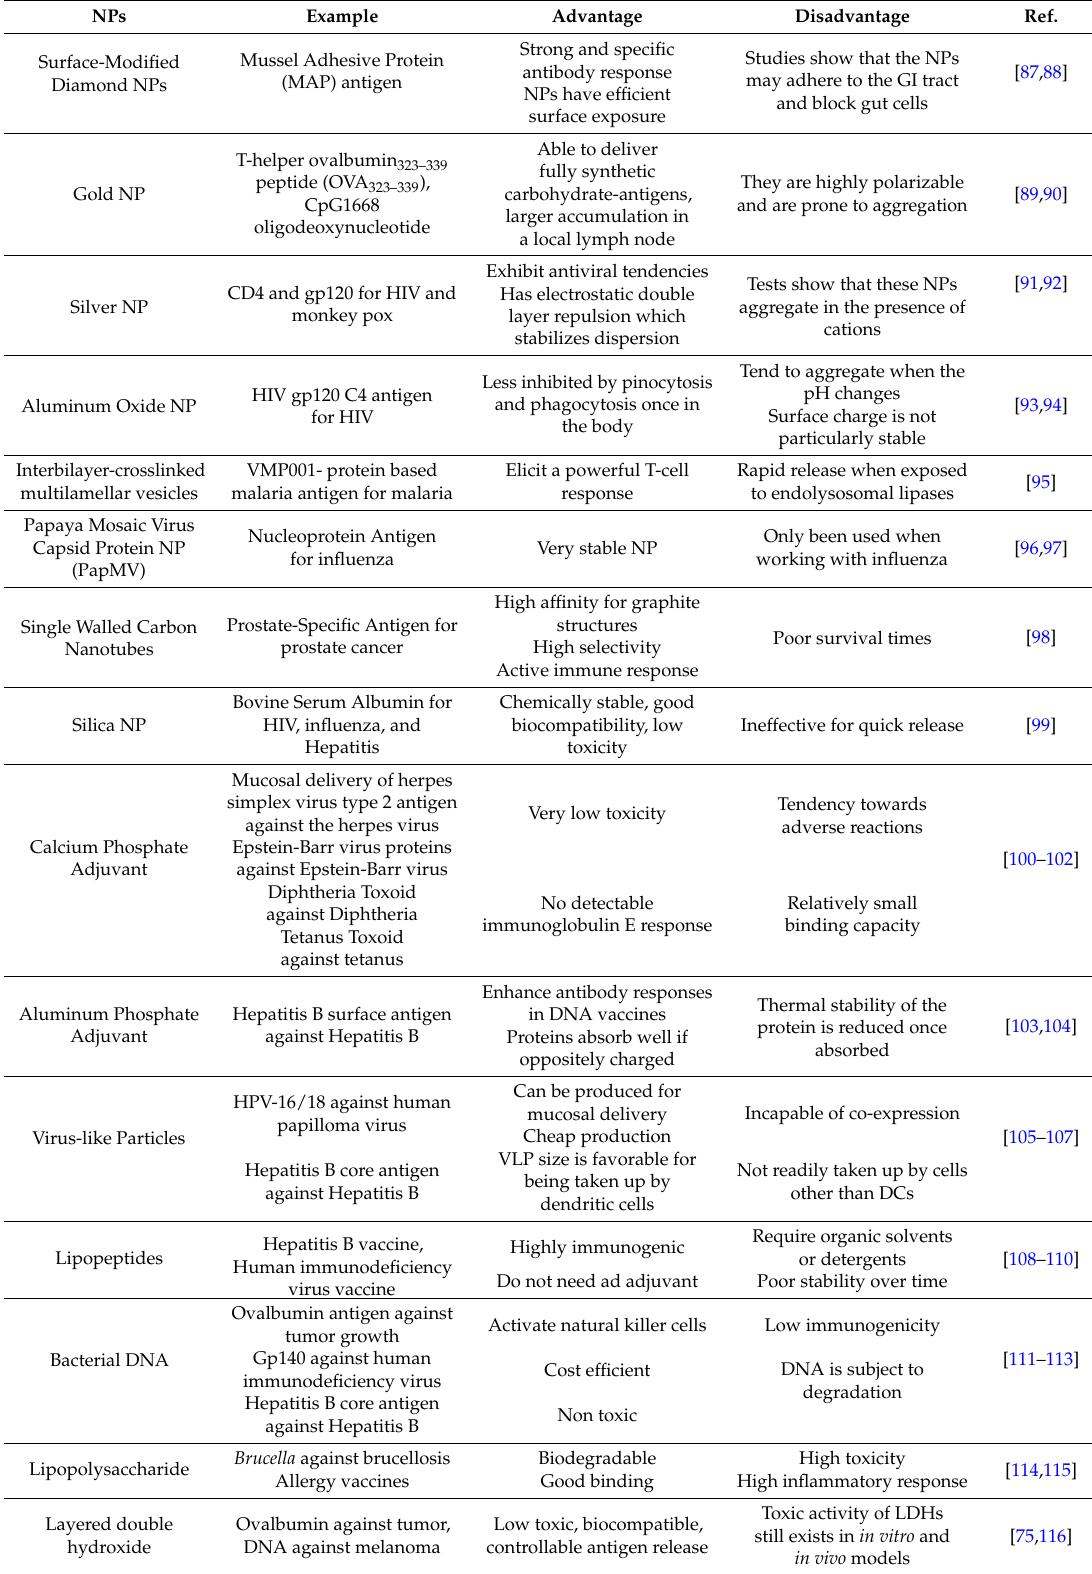
Table 4. Summary of other NPs-based antigen delivery